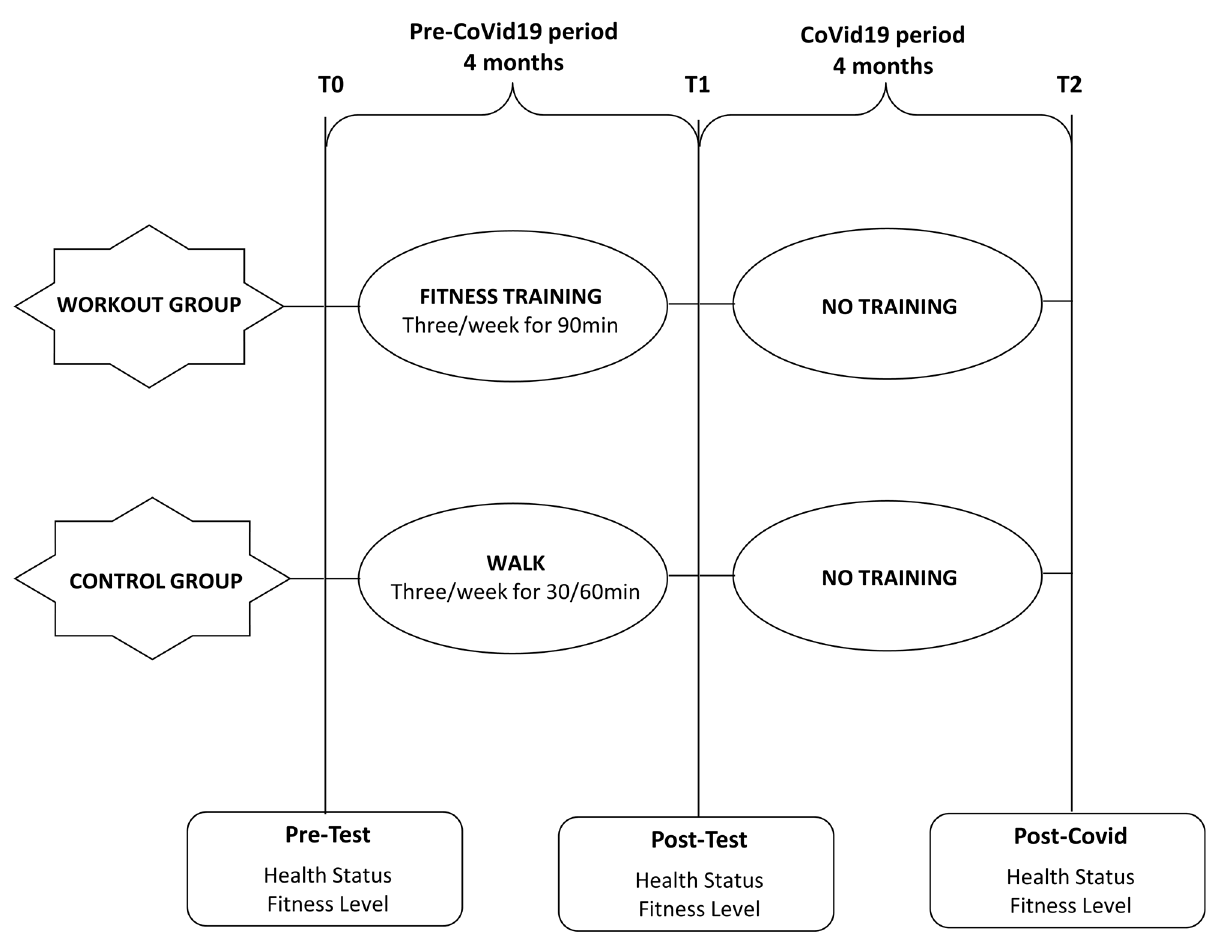
Figure 1. Study design.